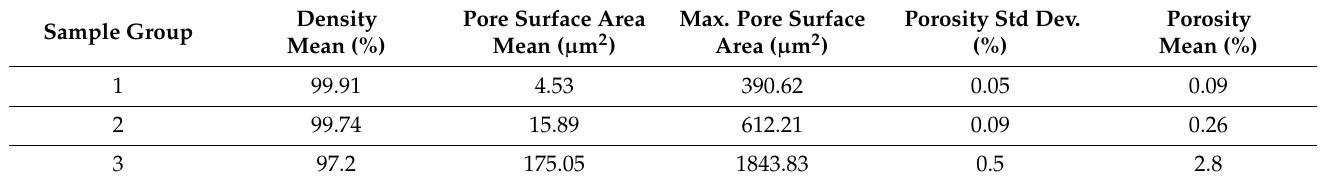
Figure 3. ( a ) Grinding-induced plastically deformed layer thickness and ( b ) surface of the ground specimens highlighting the machining marks. (BD) Build direction, (GD) grinding direction. Table 2. Porosity analysis of the specimens with various energy input density